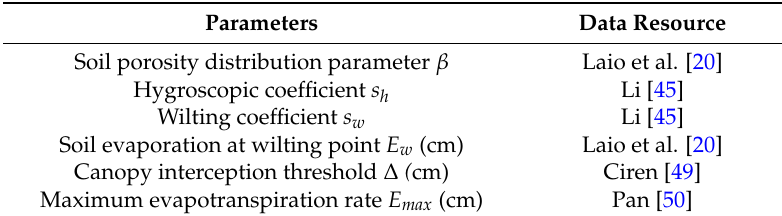
Table 3. Data resource of some model parameters.